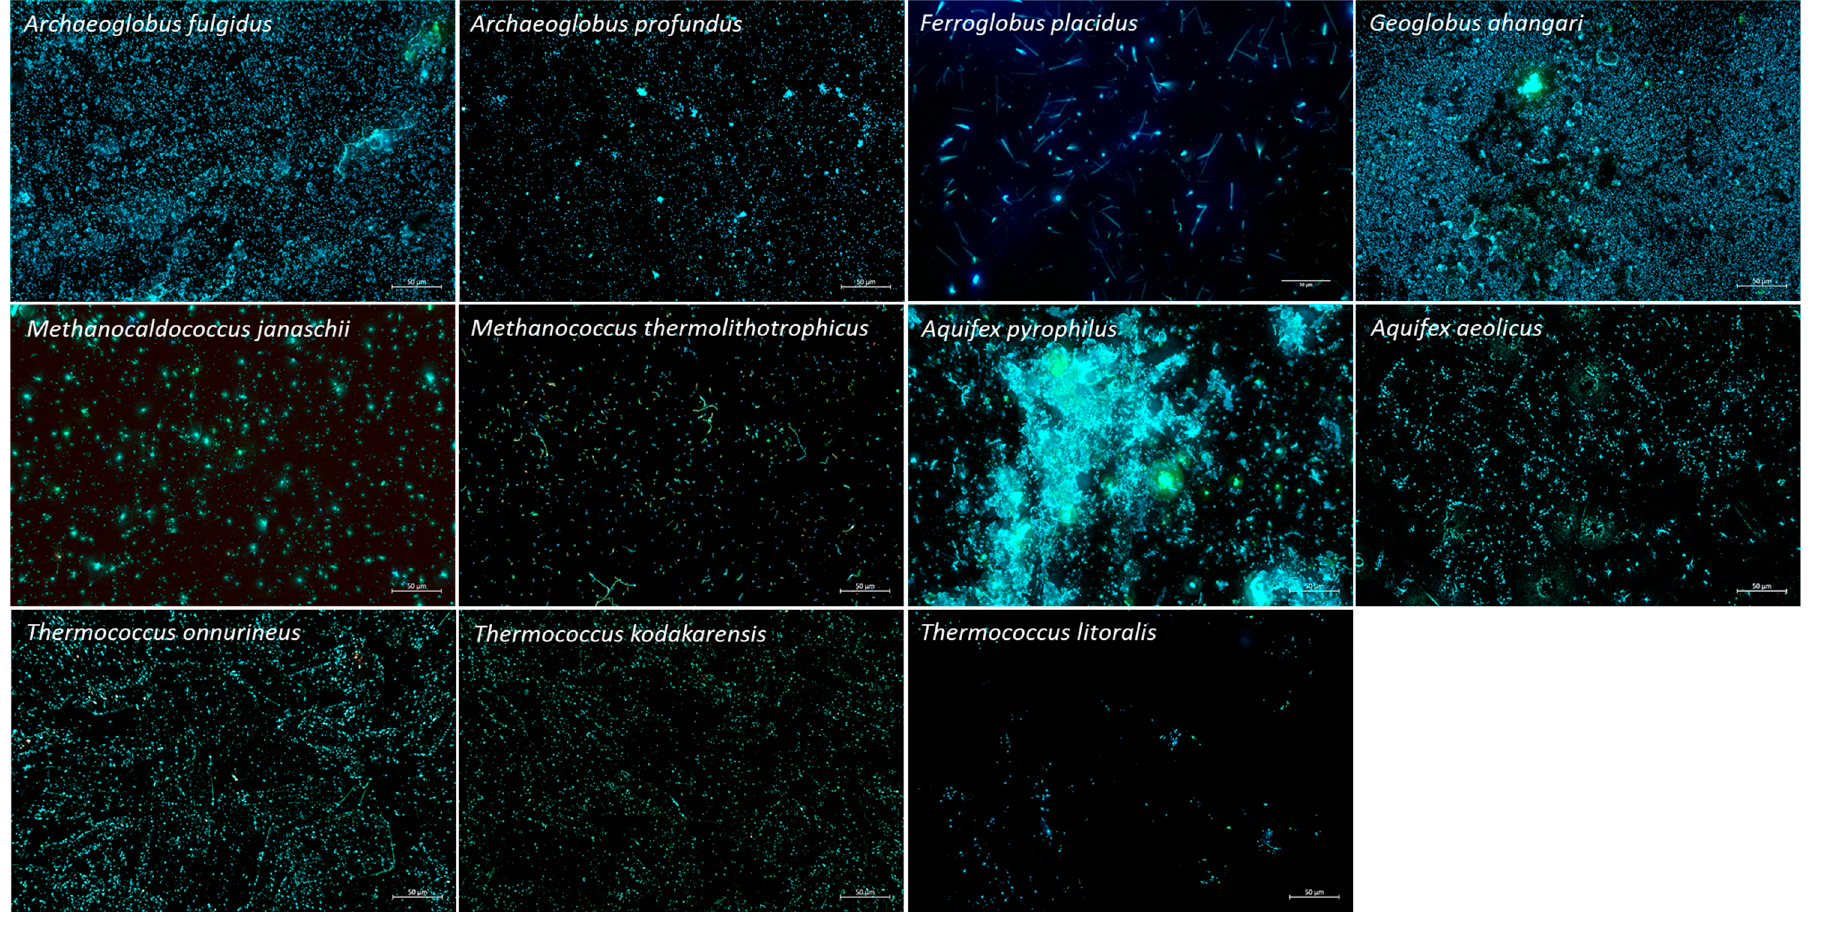
Figure 1. Biofilm formation on the graphite plate cathode during screening experiments as viewed under the fluorescence microscope with DAPI ( blue ) and Acridine orange ( green ). Scale bars are 50 μ m.